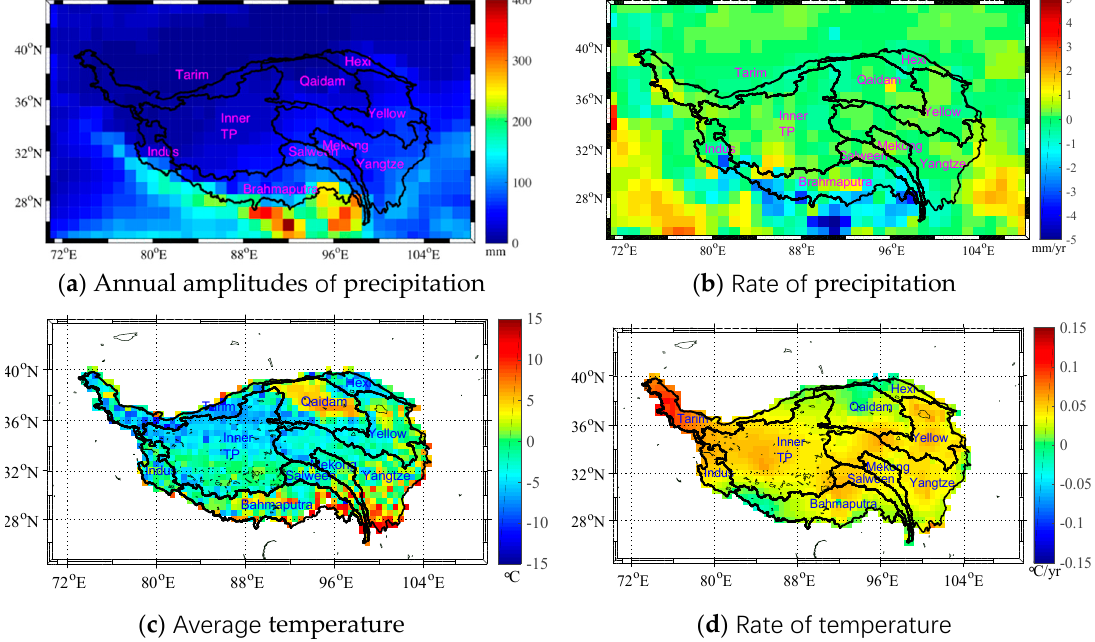
Figure 7. Annual amplitudes ( a ) and rates ( b ) of precipitation. Air temperature averaged over 15 years between 2002 and 2016 ( c ), and its annual rates ( d ).